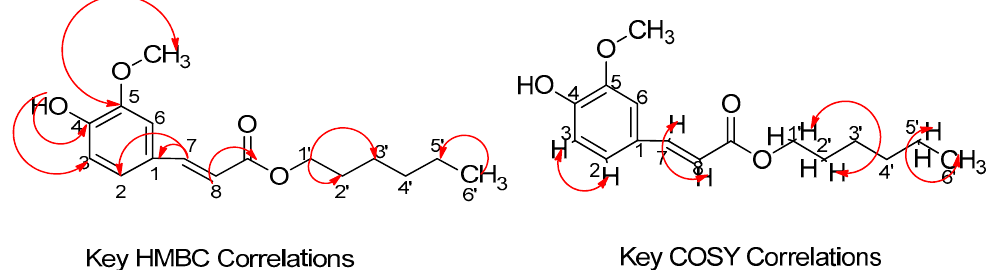
Figure 2. Significant HMBC and 1 H- 1 H COSY Correlations for FEQ-2 isolated from the methanol extract of E. spiralis stem bark.